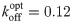
Model behavior and model parameters value selection.A and B) Increasing the strength of pheromone stimulation (S) leads to increasing levels of spatial segregation and for a given S, depending on the spatial correlation length χ and the endocytosis rate koff the cell will polarize or not. Shown are kymographs from simulations (y axis, membrane position; x axis, time). Particle density is in absolute value. On the left we see an unpolarized cell and a polarized one on the right. C) Representation of mean time polarization isovalues for S = 1 nM as a function of the spatial correlation length χ and the endocytosis rate koff. If the numerical simulations did not lead to a polarized state before 10 hours, we considered the cell to be non-polarized. D) Representation of the cost function (labeled as fit quality) depending on χ and koff, allowing us to determine the optimal pair of values (χ, koff that fit the data (Fig 2C). E) For the optimal values of χopt = 2.5 × 105
μm2/s, koffopt=0.12 s−1 and δopt = 0.2, we show the simulated timing of polarization for solutions to our model under varying pheromone concentration compared to the experimental data for polarization timing. The inset shows the standard deviation of the timing of polarization for solutions to our model under varying pheromone concentration compared to the experimental data for polarization timing. F) For the same optimal parameters (χopt,koffopt,δopt), we represent the numerical fraction of cells which polarize under varying pheromone concentration. Before fitting the model parameters with the data, we defined the numerical criterion for polarization. Following [42], we considered that polarization occurred when more than 50% of the total membrane protein pool was located in a window of 10% of the membrane. Hence, a numerical simulation corresponded to a polarization state if there existed a time for which more than 50% of the total membrane Cdc42 was located in less than 10% of the perimeter of the cell boundary (S1 Text).